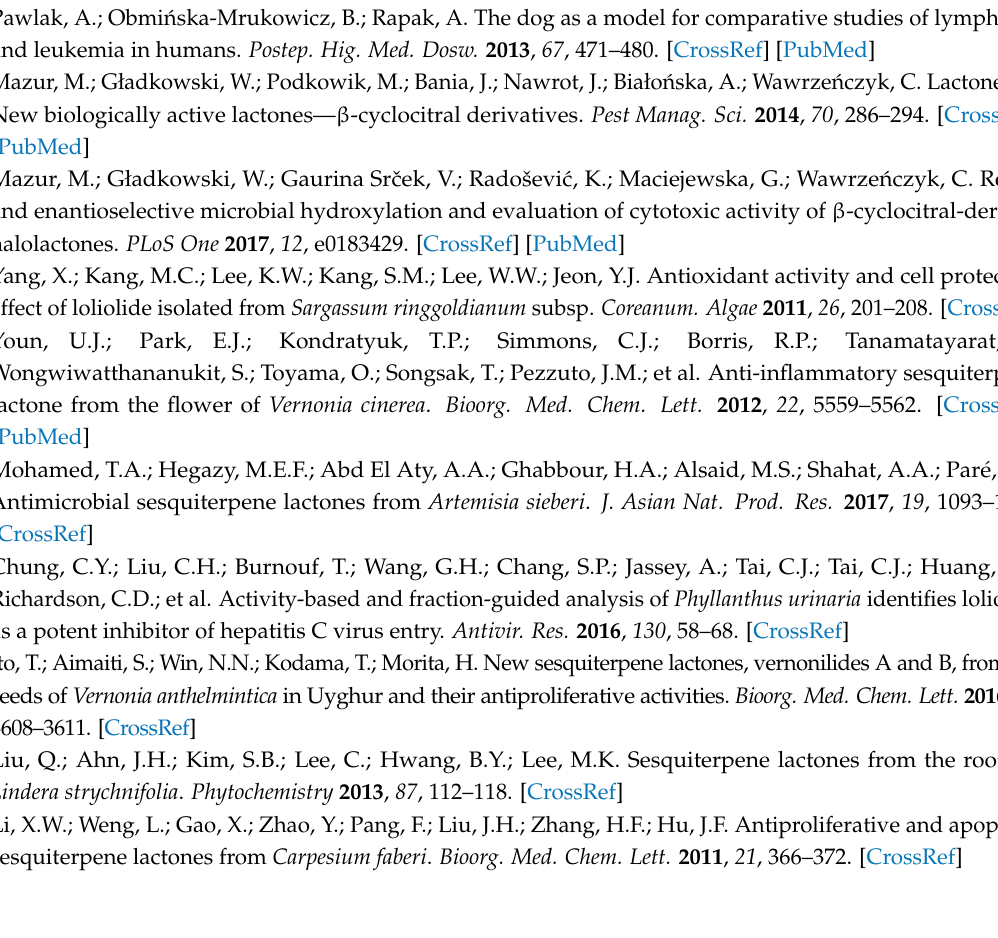
C-NMR of lactone 2 , Figure S3: HMQC spectrum of lactone 2 , Figure S4: HMBC spectrum of lactone 2 , Figure S5: 1 H-NMR of lactone 3 , Figure S6: 13 C-NMR of lactone 3 , Figure S7: HMQC spectrum of lactone 3 , Figure S8: HMBC spectrum of lactone 3 , Figure S9: 1 H-NMR of lactone 4 , Figure S10: 13 C-NMR of lactone 4 , Figure S11: HMQC spectrum of lactone 4 , Figure S12: HMBC spectrum of lactone 4